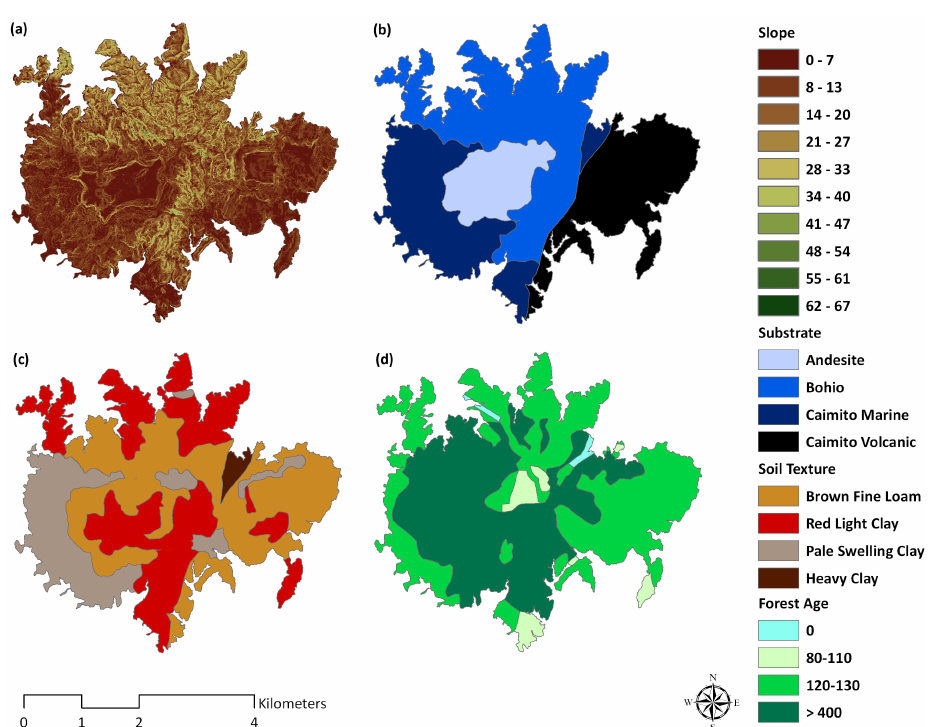
Fig. 1. Spatial variation in site factors on Barro Colorado Island, Panama (BCI): (a) slope was calculated at 1.12-m resolution from the LiDAR ground DEM, and is shown here at 5-m resolution (it was coarsened by averaging to 30-m resolution and above for input into the multiple regression model); (b) bedrock geology, mapped by Woodring (1958) with updates by Johnsson and Stallard (1989) and Baillie et al. (2006); note strike-slip fault separating the Bohio and Caimito volcanic bedrock features; (c) soil textural types mapped by Baillie et al. (2006); and (d) forest age, based on land-use history mapped by Enders in 1935.